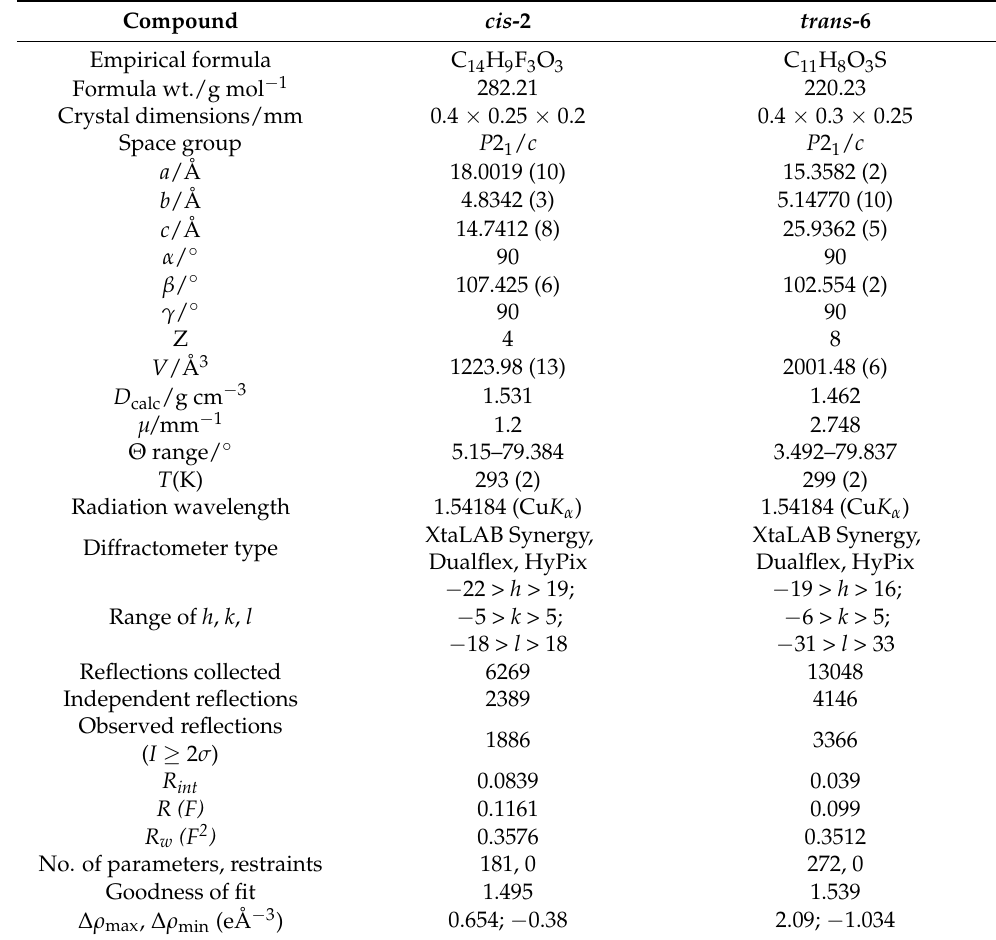
Table 3. Crystallographic data and structure refinement details for cis - 2 and trans - 6 .